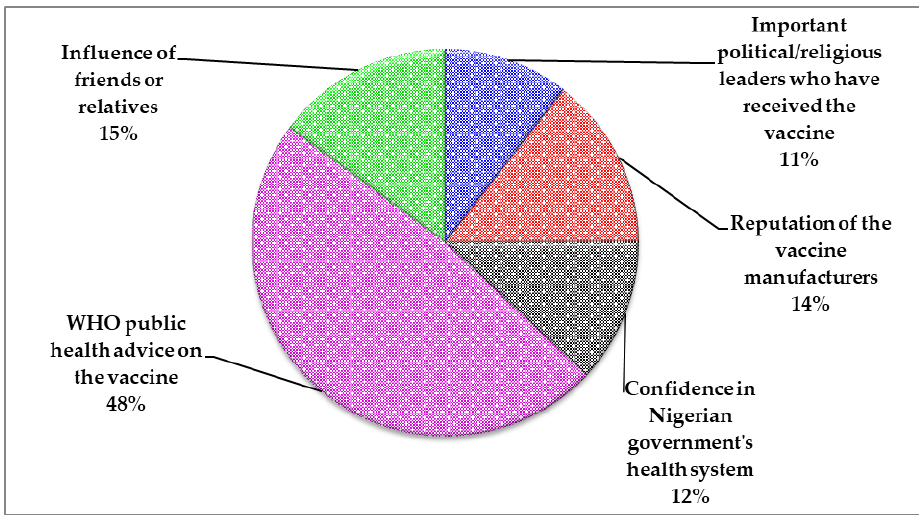
Figure 8. Reasons that informed the confidence of COVID-19 vaccinated respondents on the safety and efficacy of the vaccine.